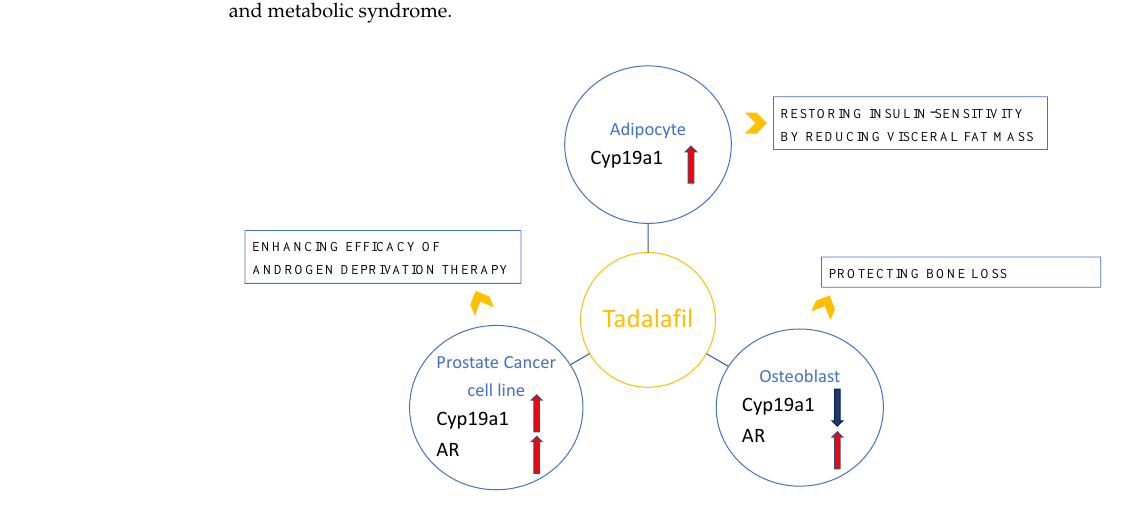
Figure 1. Schematic representation of the relationship between tadalafil and steroid hormone path- ways in adipocyte, osteoblast and prostate cancer cell lines and the clinical translational perspective of tadalafil actions. Tadalafil may modulate the expression of molecules such as Cyp19a1 and the androgen receptor (AR). In particular, tadalafil increases the expression of AR in osteoblast and prostate cancer cell lines and decreases Cyp19a1 expression in osteoblasts, whereas it increases the expression of Cyp19a1 in adipocyte and prostate cancer cell lines.